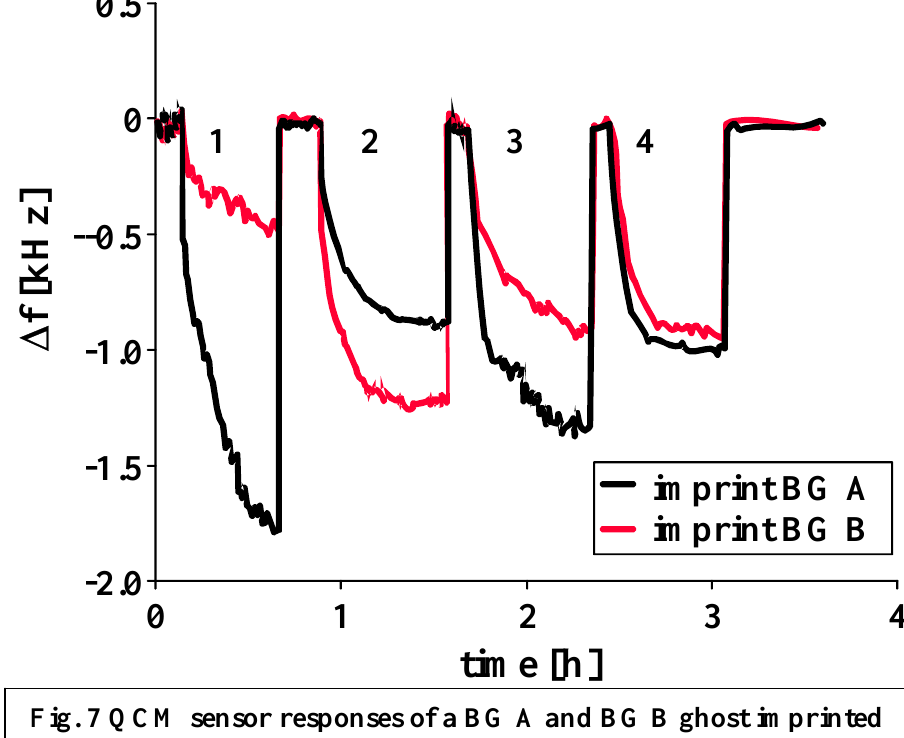
Fig. 7 QCM sensor responses of a BG A and BG B ghost imprinted layer,